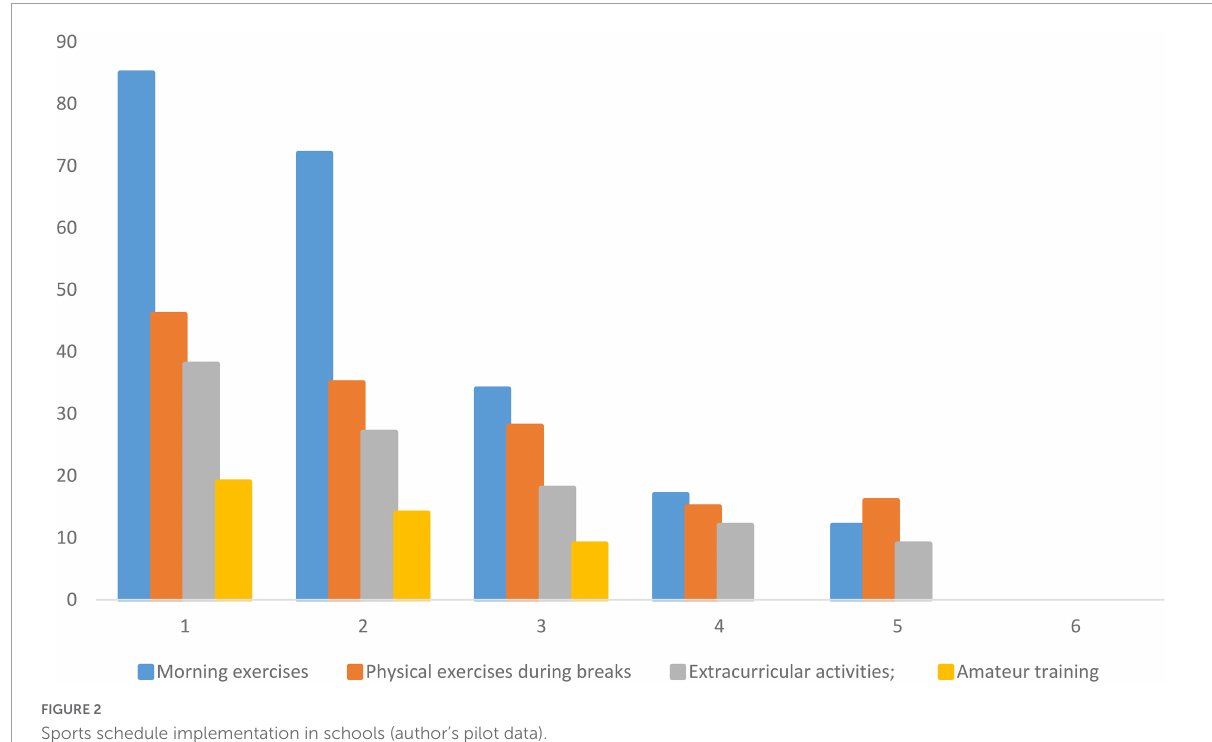
FIGURE2 Sports schedule implementation in schools (author’s pilot